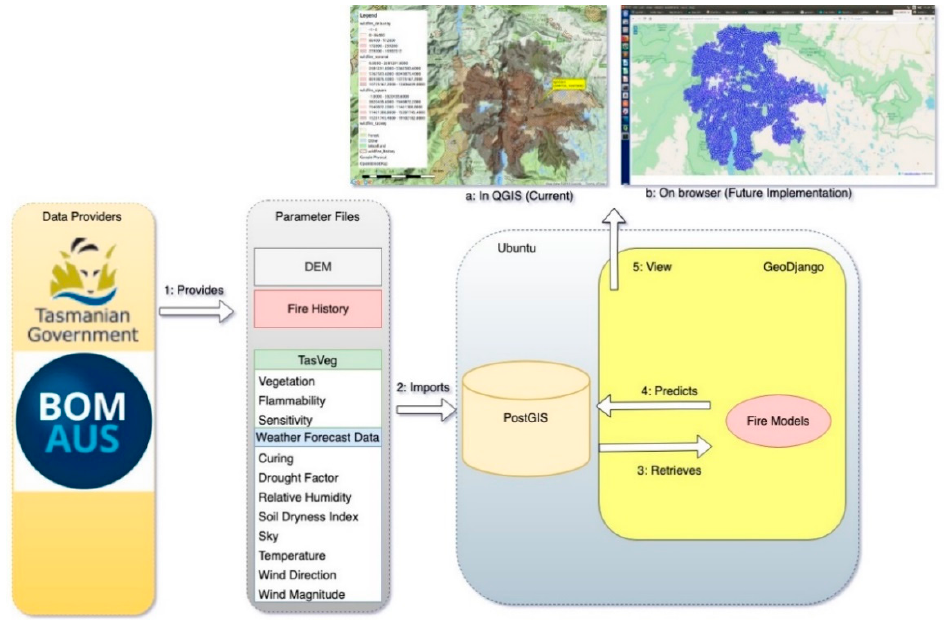
Figure 2. System Figure 2. System Architecture.